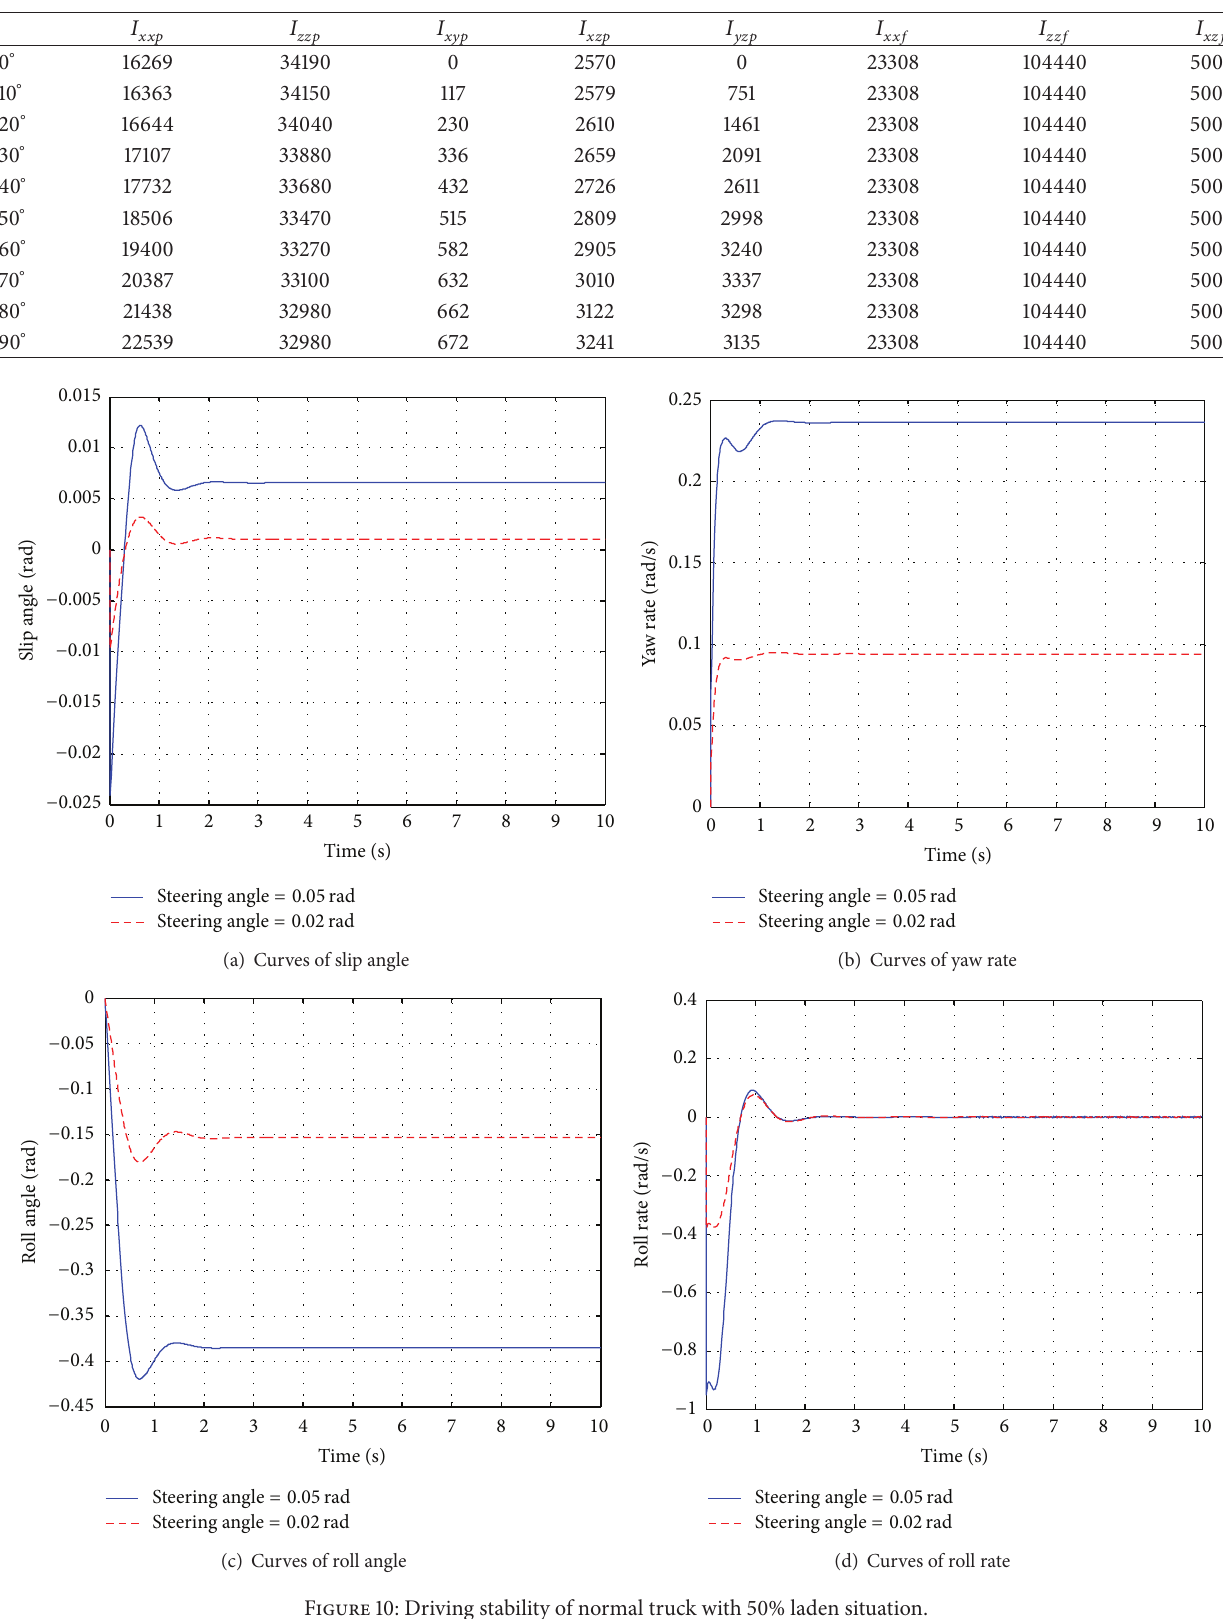
Table 3: The inertia tensors of the pendulum mass and the fixed liquid mass when the liquid fill level is 0.8.